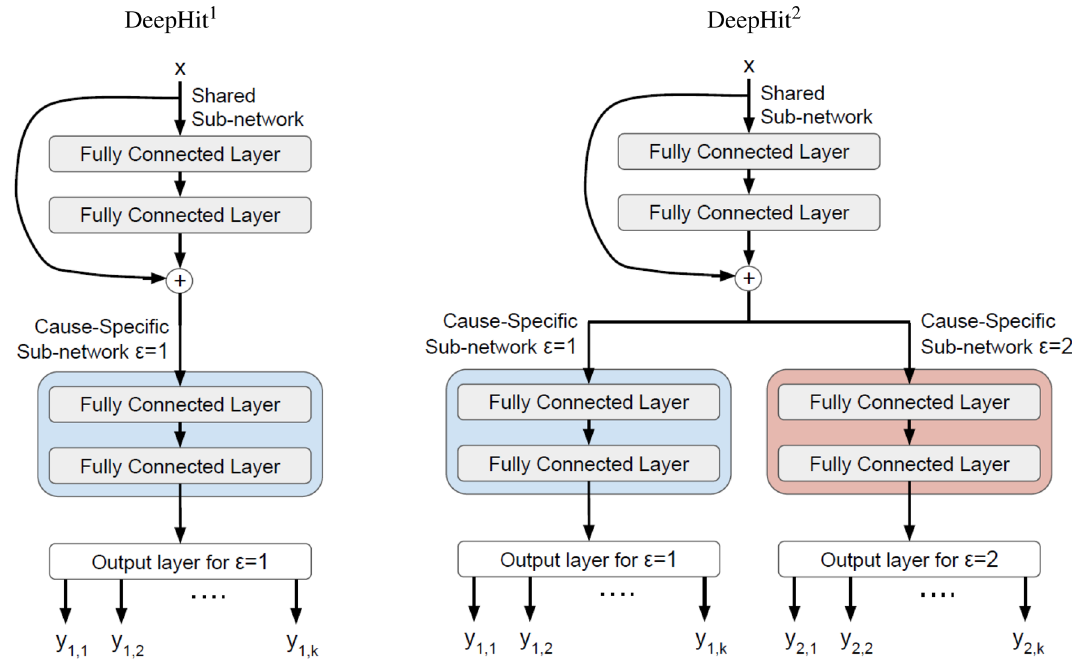
Figure 2. Visualization of the DeepHit 1 and DeepHit 2 architectures used in the